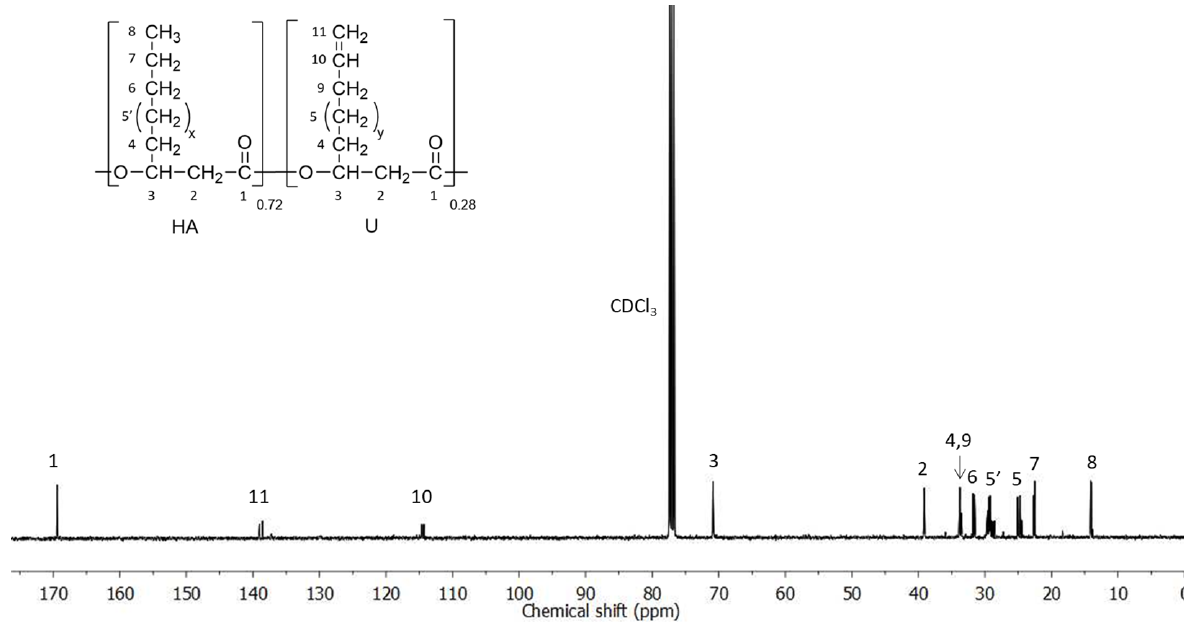
Figure 1. 13 C NMR spectra of PHAU. (x = 1 or 3 or 5; y = 2 or 4).